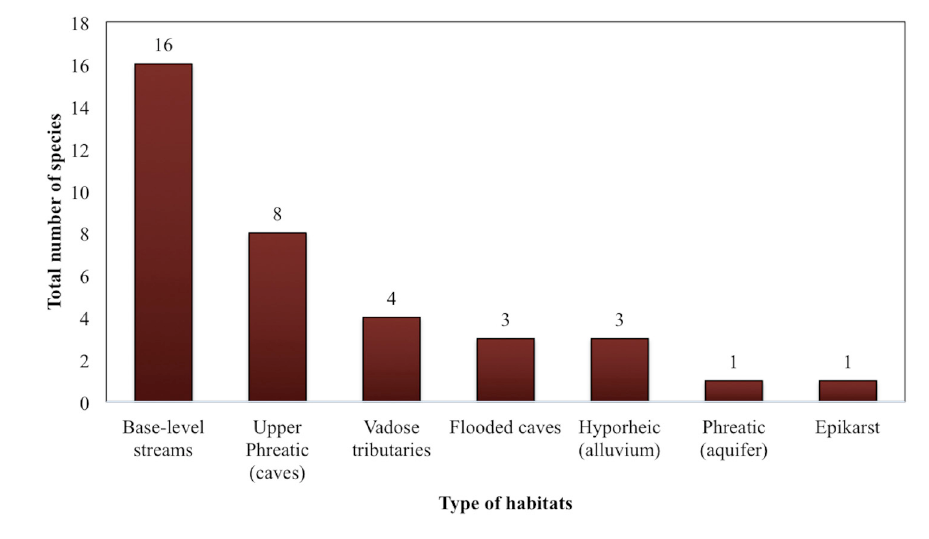
FIGURE 4 | Distribution of Brazilian subterranean fish species according to the type of